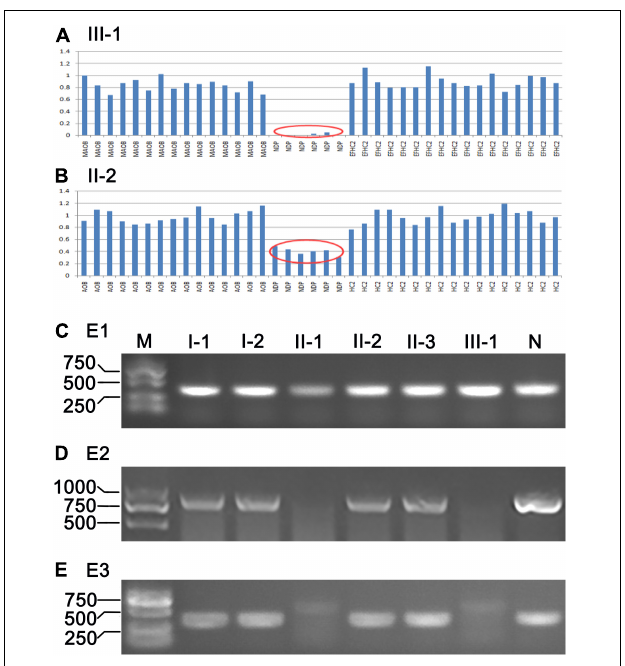
FIGURE 6 | Results of WES and PCR. (A,B) Results of WES of III-1 and II-2, respectively. Red oval tag indicates exons of NDP were deleted. (C–E) PCR products of exon 1–3 (E1, E2, and E3) of NDP of the ND family; M, DNA ladder (DL2000); N, normal